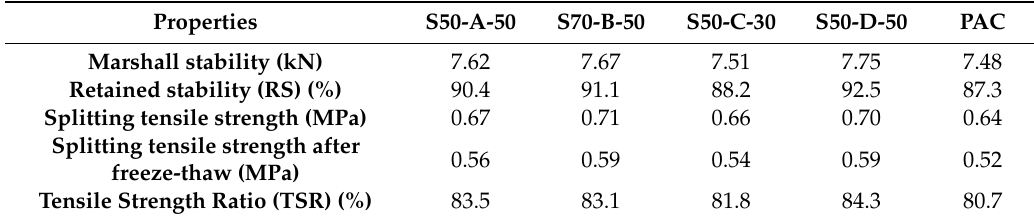
Table 13. Moisture susceptibility test results (one freeze-thaw cycle).